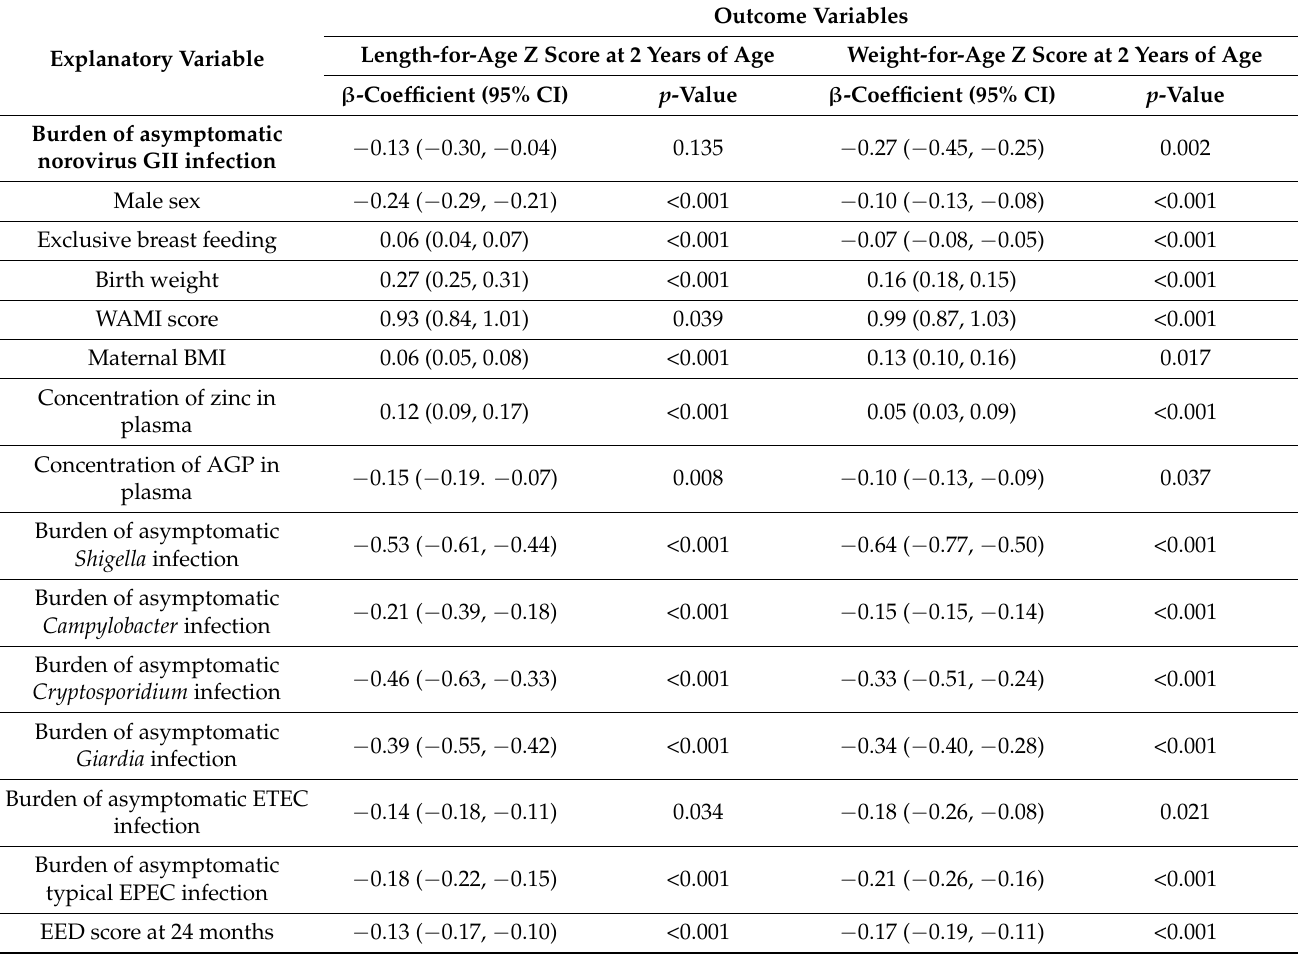
Table 5. Association of burden of norovirus GII infections with linear growth and ponderal growth at 2 years of